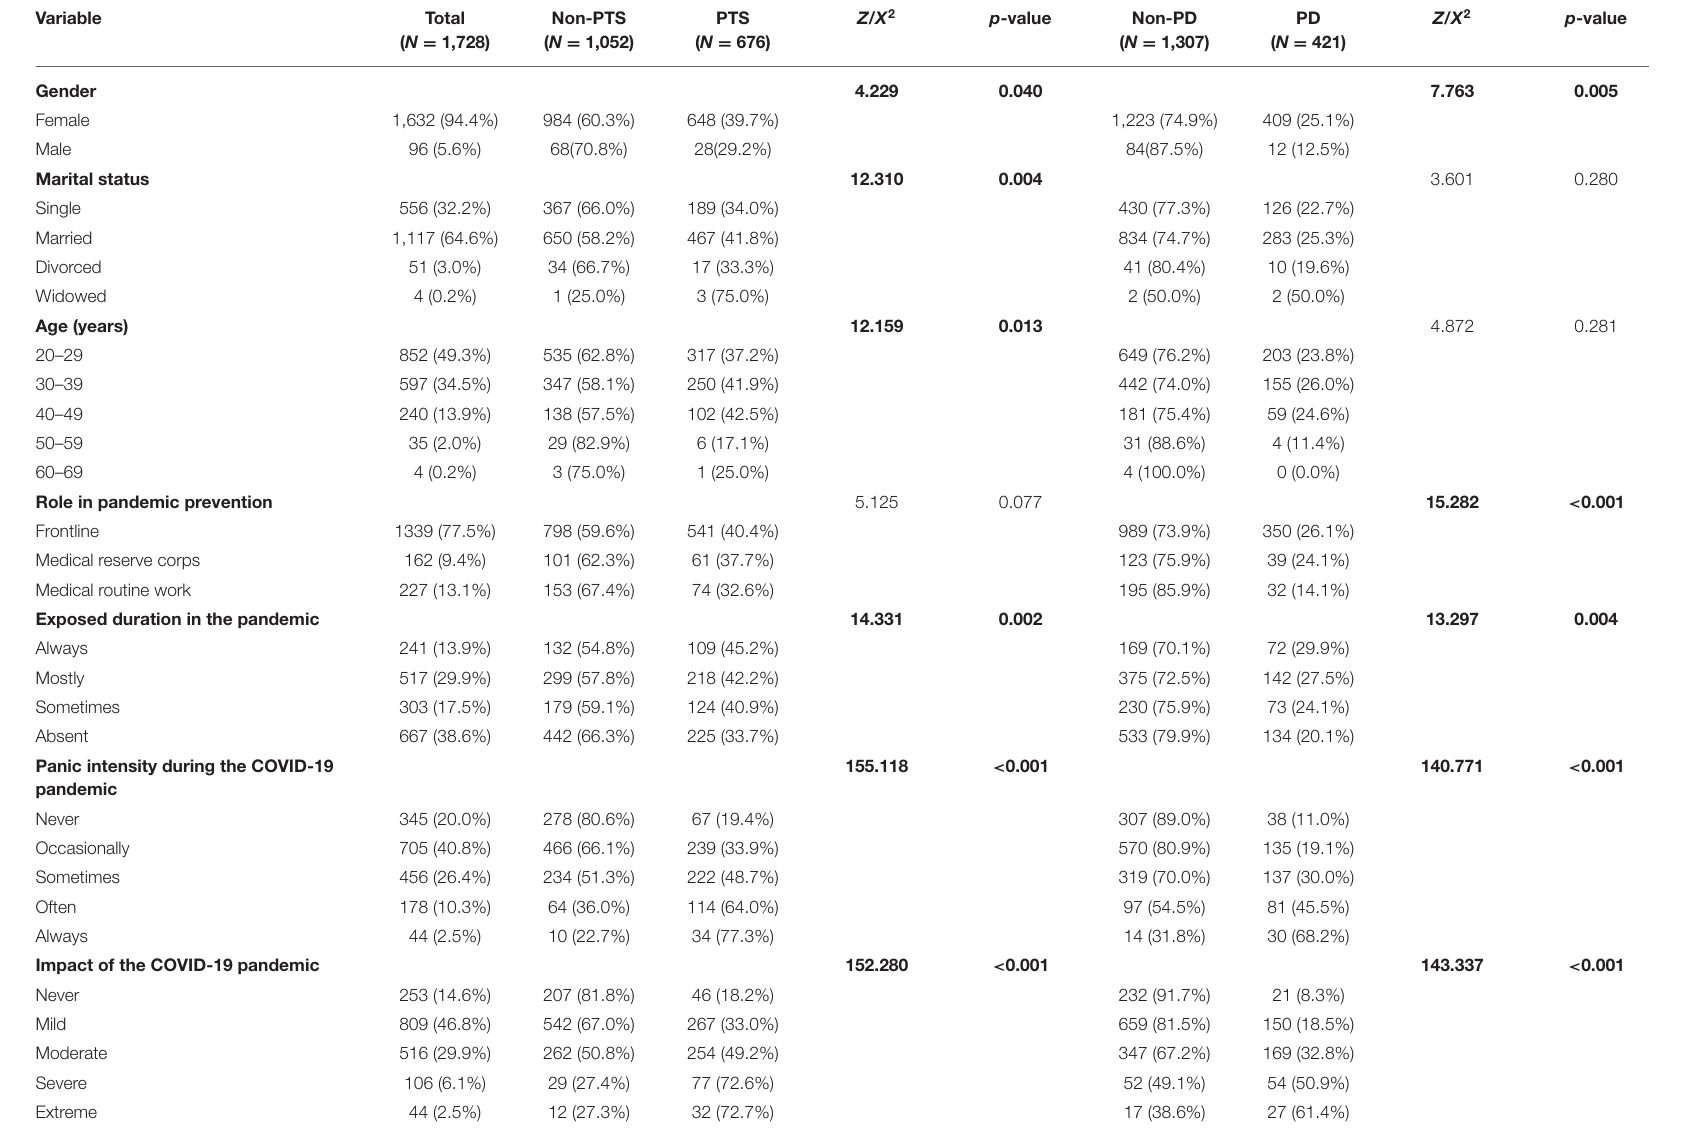
TABLE 1 | Demographic characteristics of the sample ( N =